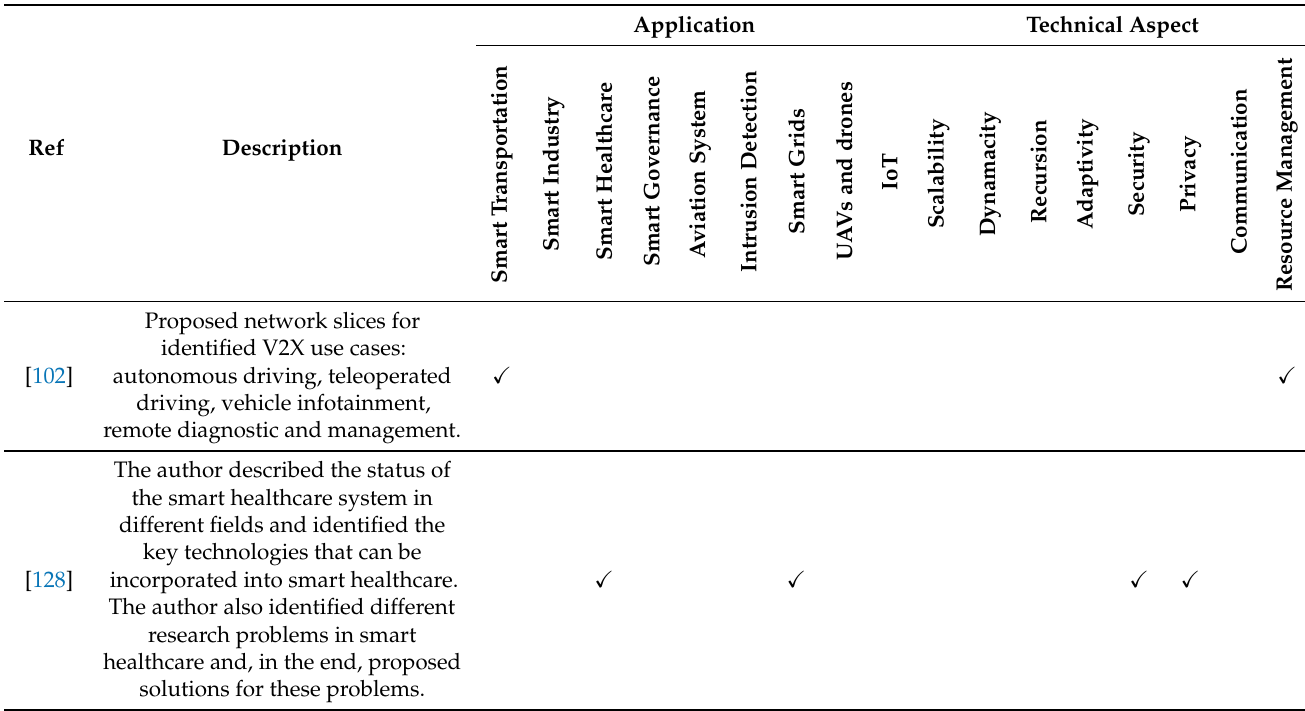
tabular form. Table 3. XAI Application Summary of related